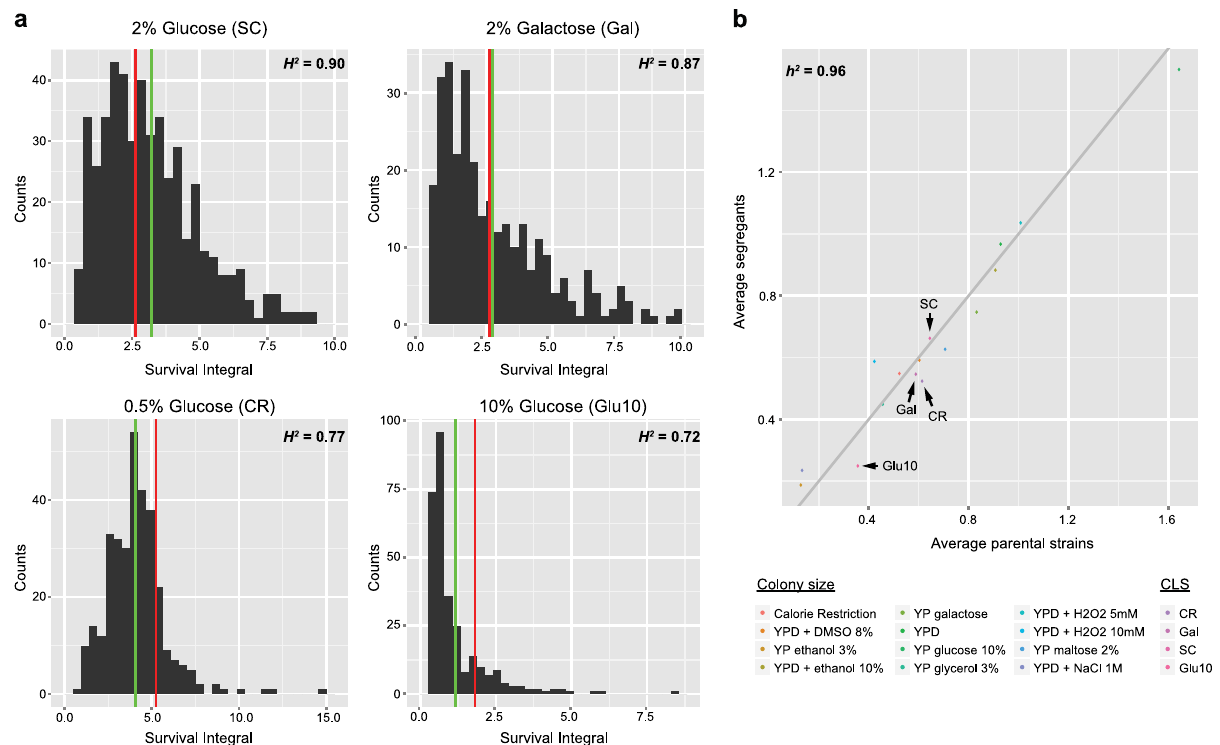
Fig. 3 Heritability analyses of CLS in a segregating yeast population. a Broad-sense heritability H 2 was estimated as described in Supplementary Information. Distributions of SIs determined for the entire “ sake × tecc cross ” are shown for the four tested growth conditions. Average of SIs for parental strains and the segregating population are depicted in red and green, respectively. b Narrow-sense heritability h 2 was estimated by comparing the averages of the CLS data obtained for the parental strains and the segregants in the indicated conditions. Average colony sizes obtained for parental and segregant strains in 12 growth conditions were also compared. For a better chart clarity, CLS data are represented at a 1/5 ratio for SC, Glu10, and Gal conditions and a 1/10 ratio for the CR condition. The h 2 was estimated based on